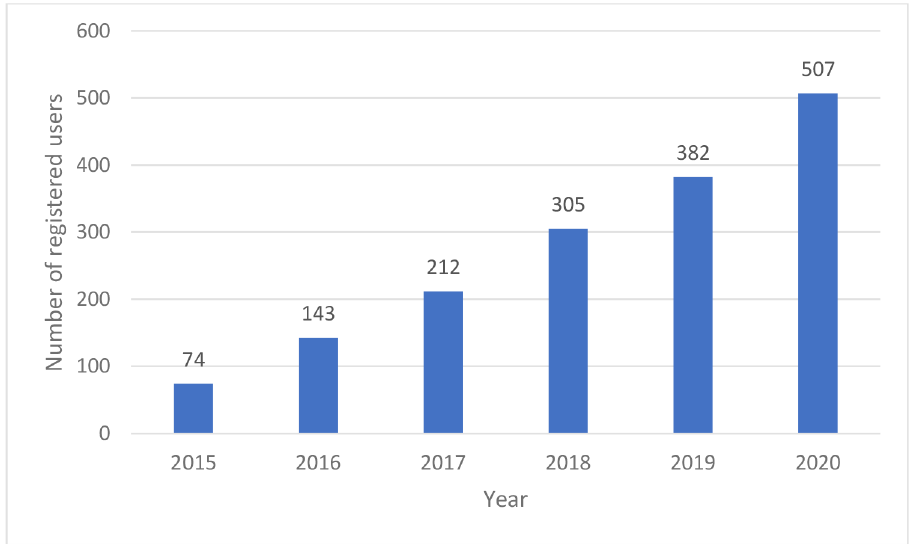
Figure 2: Number of registered users of the PHRN online application system by year